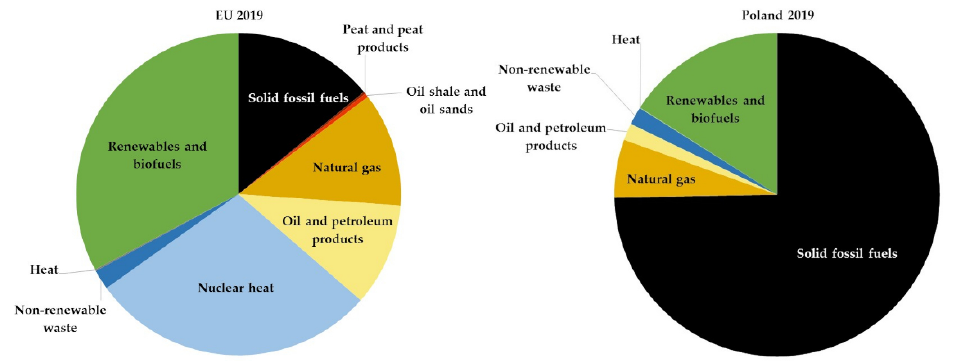
Figure 2. Primary energy production by source in Poland and the EU in 2019 [7].